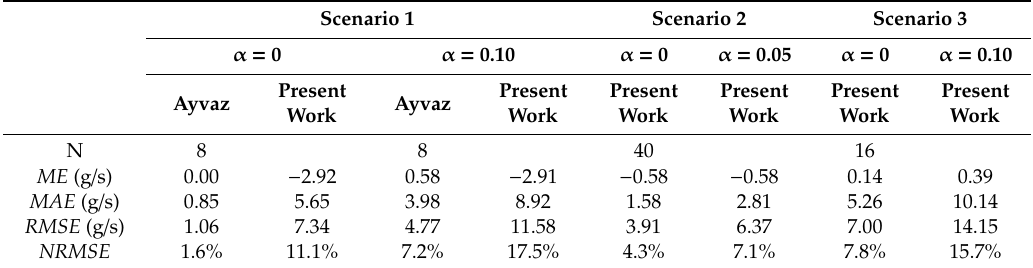
Table 4. Mean error (ME), mean absolute error ( MAE ), root mean square error ( RMSE ) and normalized root mean squared error ( NRMSE ), computed for case study 1 on source fluxes (g /